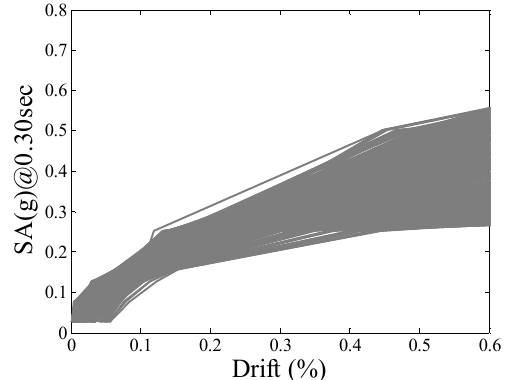
Figure 10 Structure response curves obtained through IDA of SDOF systems. Figure 11 Fragility functions for Himalayan DS masonry structures obtained through NDRM. Fig. 11. Fragility functions for Himalayan DS masonry structures obtained through NDRM.